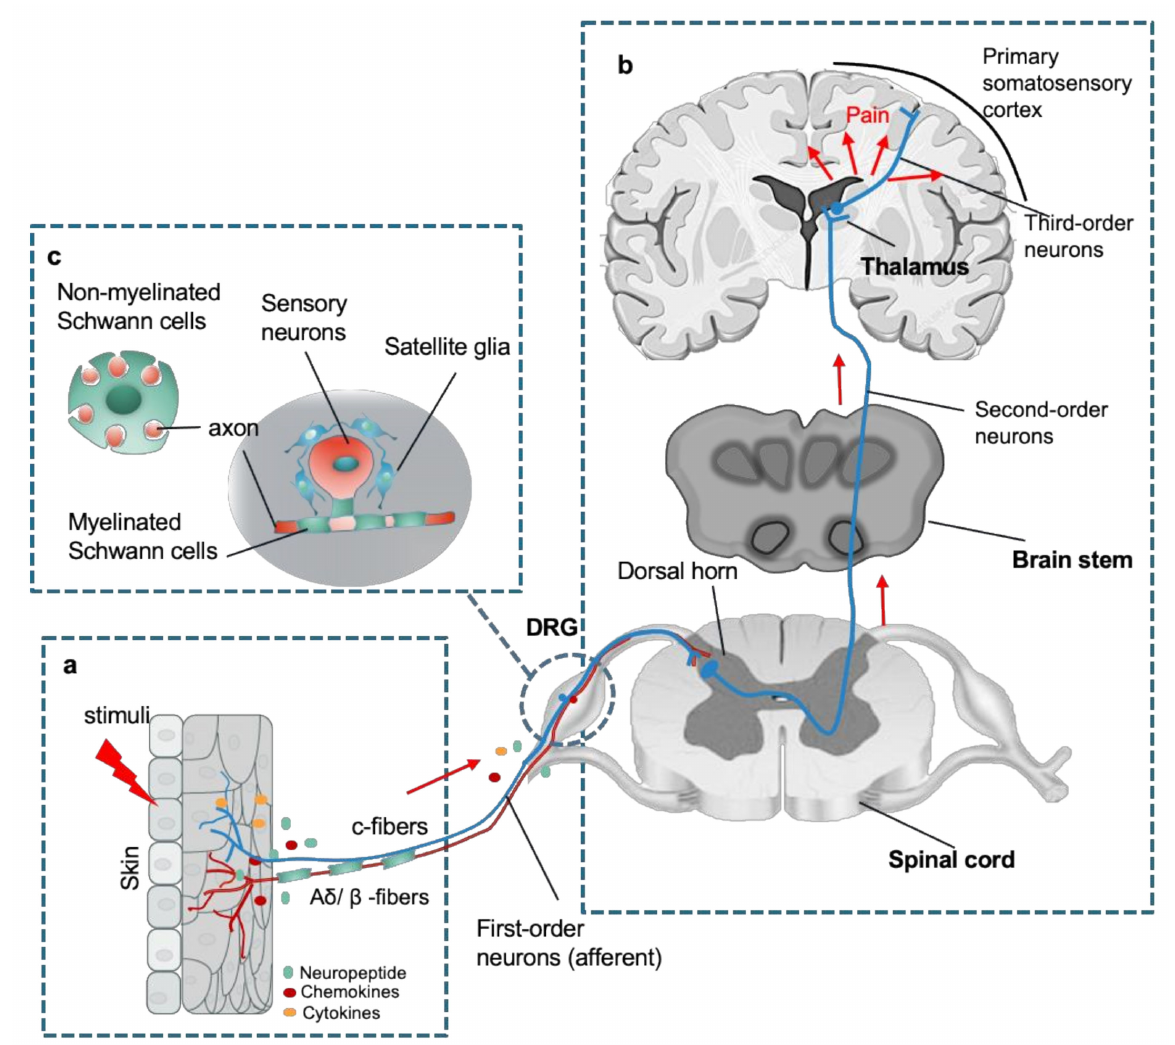
Figure 1. An overview of peripheral nervous system (PNS) in the sensory pathways leading from the skin to the brain. ( a ) The peripheral nerve endings comprise both unmyelinated c-fibers and myelinated A δ / β -fibers in the skin that sense a stimulus, where chemicals such as inflammatory mediators and neuropeptides released from the injury site or the nerve endings activate the receptors and channels on the adjacent peripheral nerve terminals, subsequently resulting in initiating an action potential at the initial segment of the axon. ( b ) The axon of the peripheral sensory neuron (first order neuron) enters the spinal cord and contacts second-order neuron in the gray matter, where an action potential is generated at the initial segment of this neuron and travels up the sensory pathway to a region of the brainstem and thalamic nuclei. The sensory signal reaches the third-order neurons from the thalamus, and these project pain signaling to several cortical and subcortical regions (red arrows). ( c ) Schematic of organization of dorsal root ganglion (DRG). Sensory neuronal bodies are separated and wrapped satellite glial sheath. Myelinated Schwann cells envelop large diameter axons of sensory neurons, whereas nonmyelinated Schwann cells ensheath small diameter axons forming a remark bundle (upper left in ( b